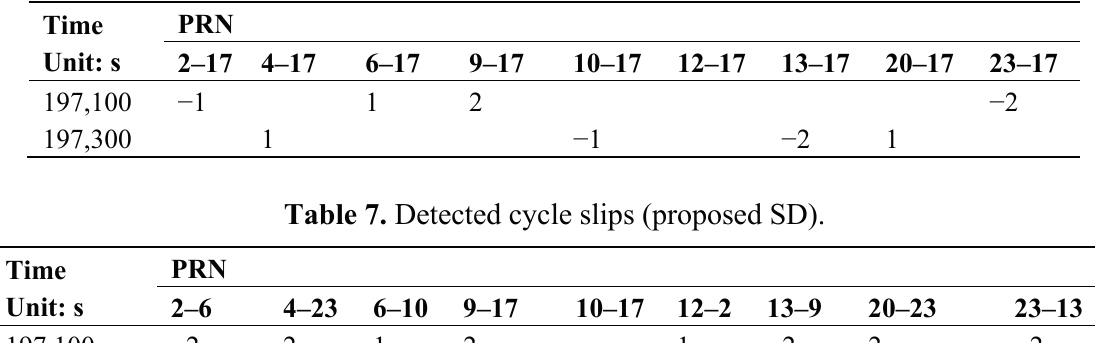
Table 6. Detected cycle slips (general SD).